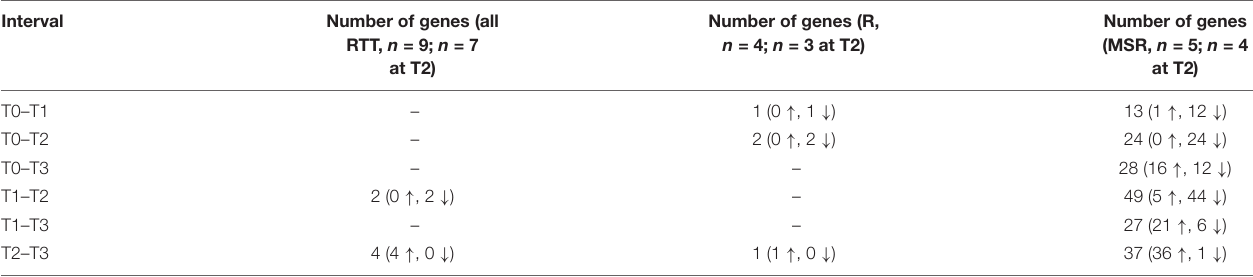
TABLE 4 | Number of genes differentially expressed in the RTT cohort throughout the trial. Interval Number of genes (all